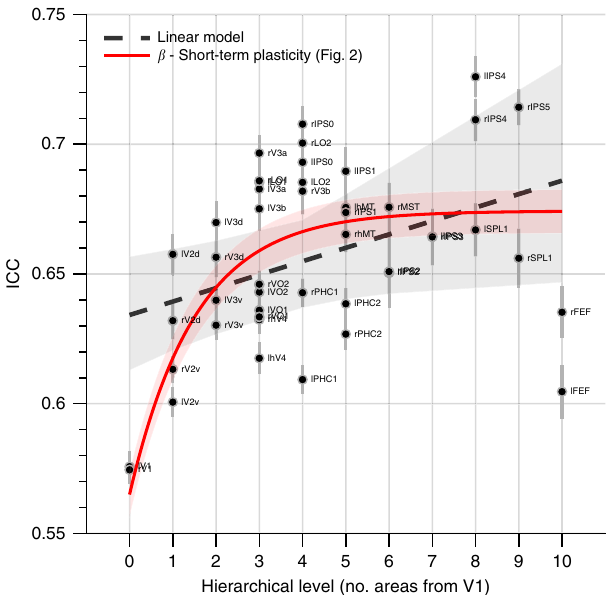
Fig. 3 RSFC differences (ICC) across session days as function of hierarchical level. Error-bars indicate the SEM. The dashed gray line and gray-shaded area indicate linear model fi ts and the bootstrapped 95% con fi dence interval, respectively. The positive relation between ICC and hierarchical level ( t -test, t 44 = 2.72, p = 9.2 × 10 − 3 ) indicates smaller differences in higher-level visual areas, which is consistent with decreased effects of short-term plasticity up the visual hierarchy predicted by the theoretical model presented in Fig. 2. The thick red line and red shaded area indicate the fi t of the short-term plasticity component and its 95% con fi dence interval (only the intercept was fi tted, the other parameters were fi xed as the estimates based on fi tting the full two-component model to the RSFC heritability data shown in Fig. 2b). Source data are provided